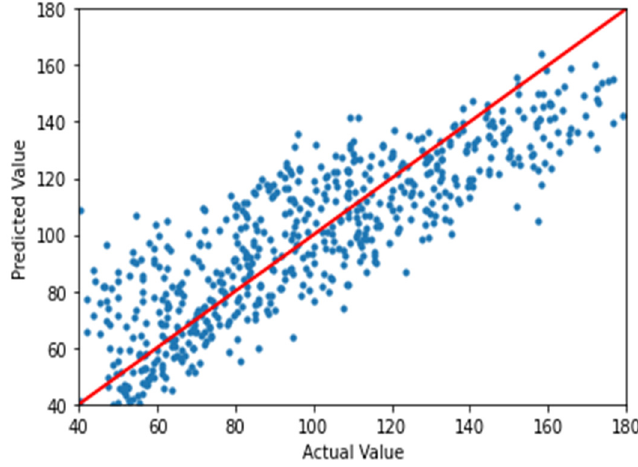
Figure 3. Simulated vs. predicted values of the area spectral density (ASE) in bits/sec/Hz/km 2 with a trend line.